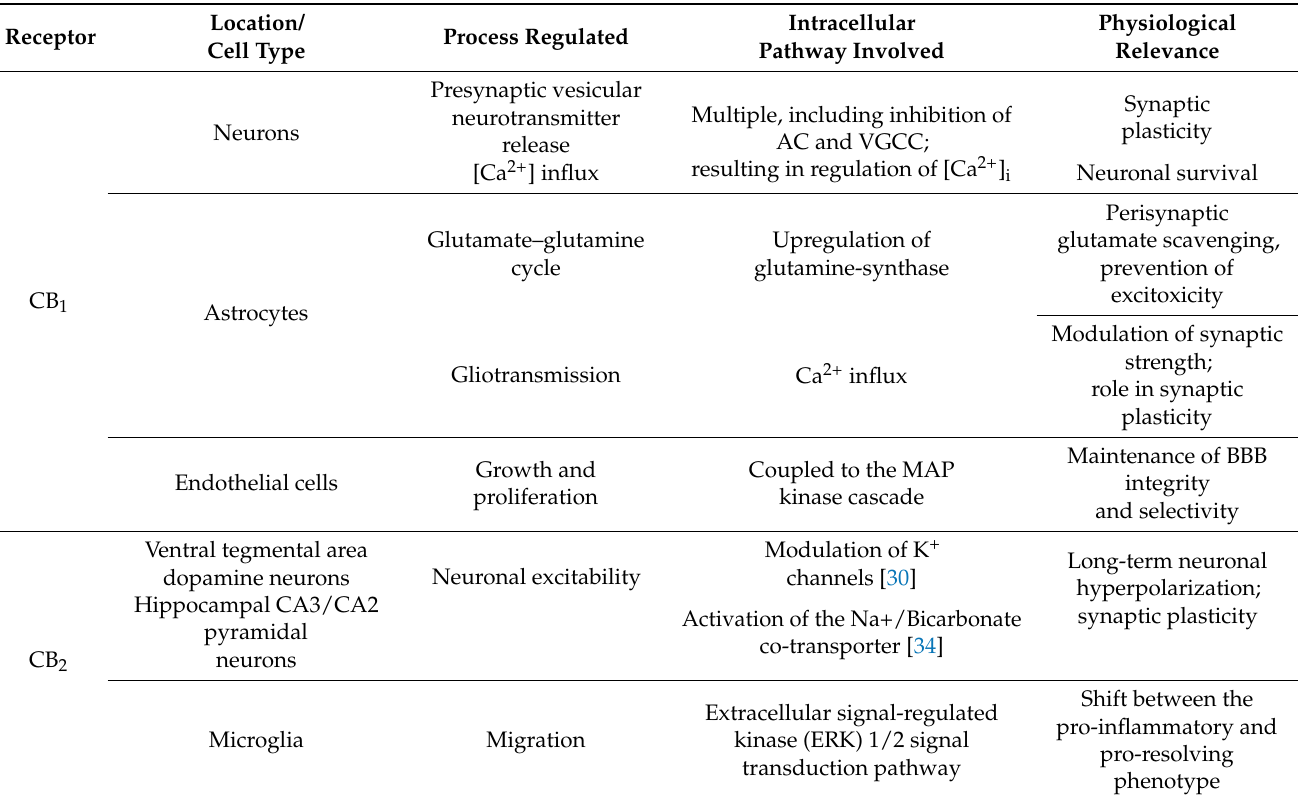
Table 1. Schematic representation of functional contribution of CB 1/2 in neurons, astrocytes and